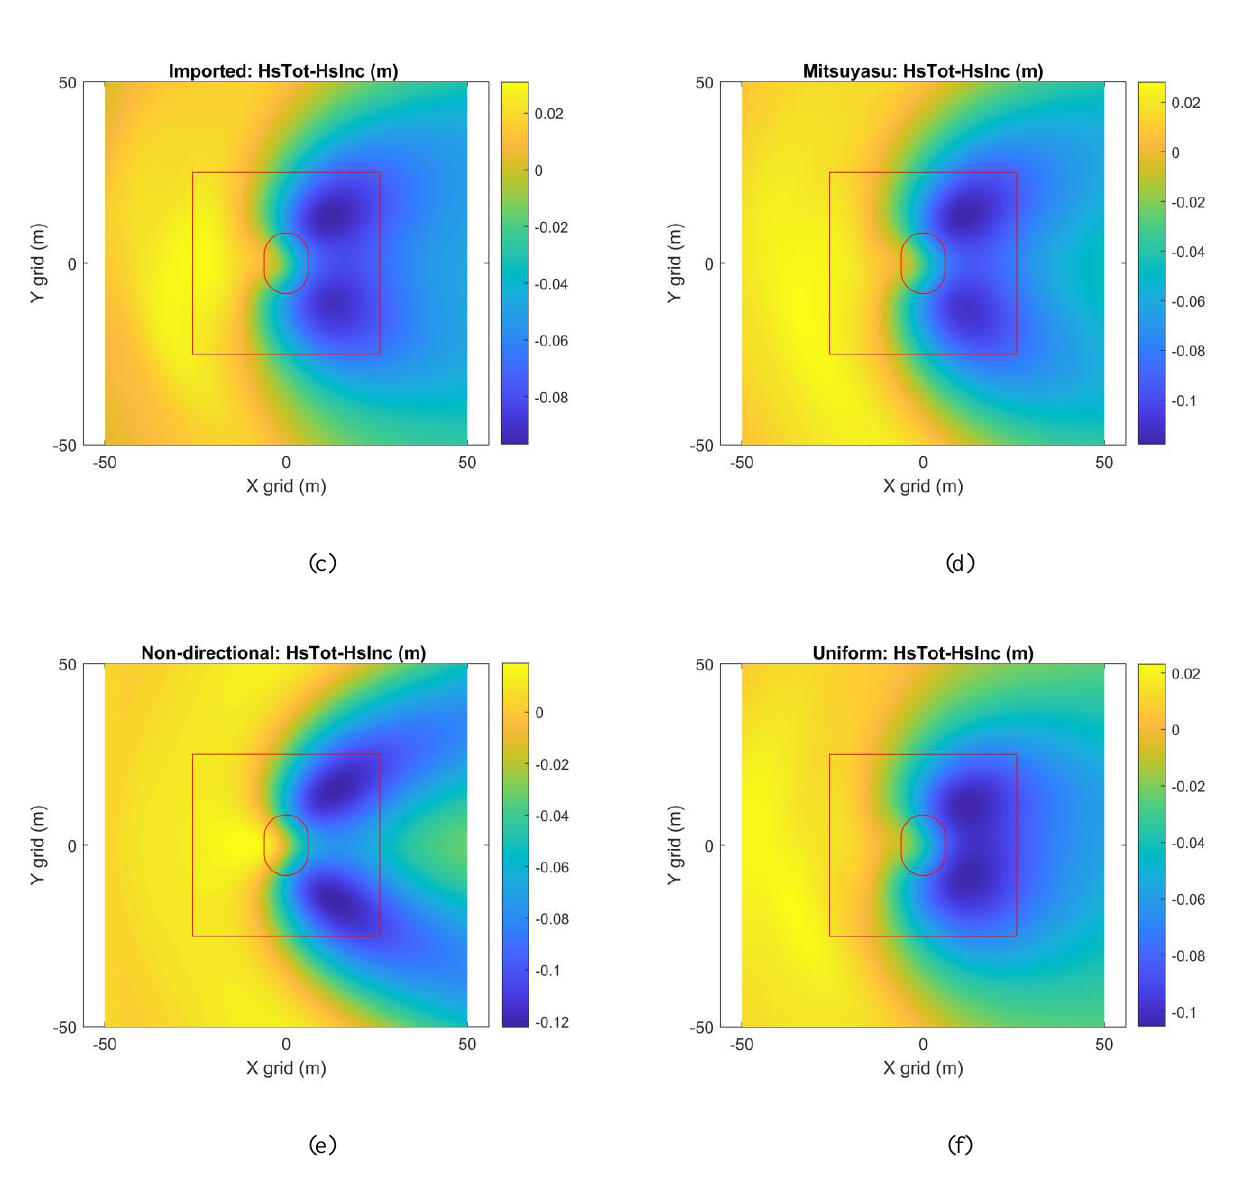
Fig. 9: Difference between the total and the incident significant height wavefields for the different distributions. Front and back of the device are left and right